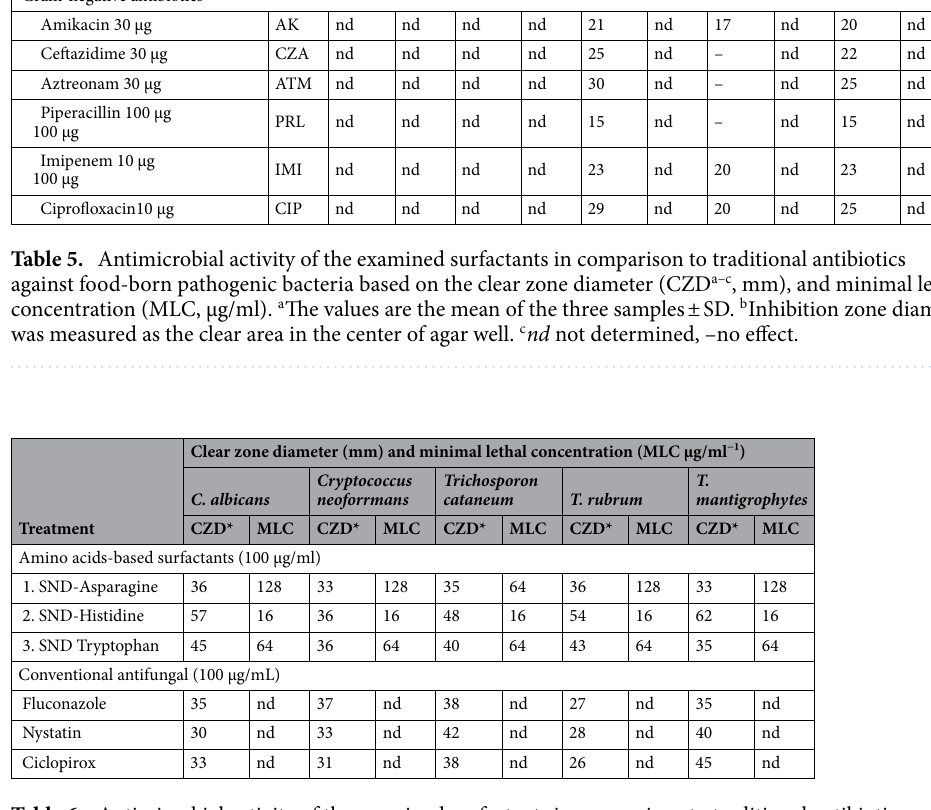
Table 6. Antimicrobial activity of the examined surfactants in comparison to traditional antibiotics against molds and dermatophyte fungi based on the clear zone diameter (CZD a–c , mm), and minimal lethal concentration (MLC, µg/ml). a The values are the mean of three samples ± SD. b Inhibition zone was measured as the clear area in the center of agar well. c nd not